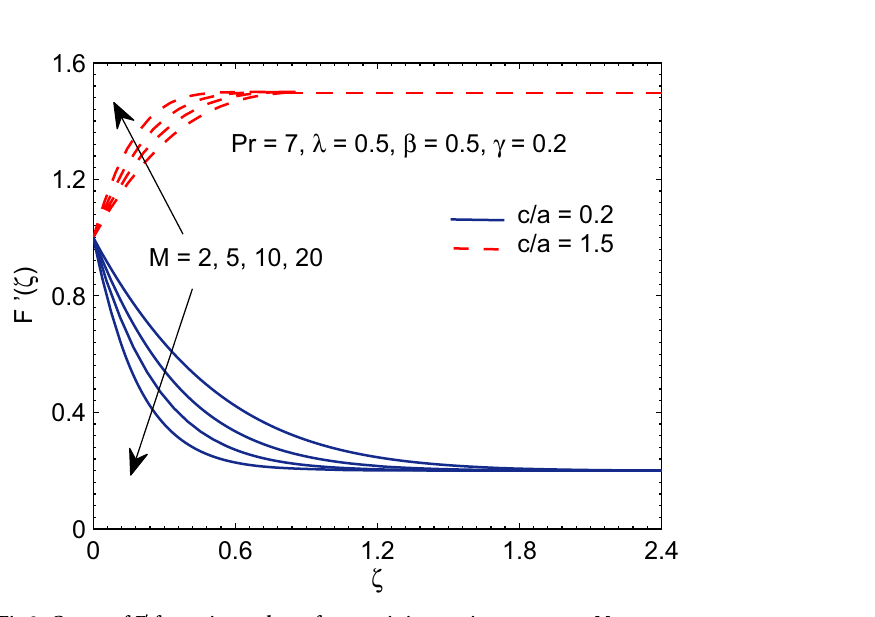
Fig 2. Curves of F 0 for various values of magnetic interaction parameter M .